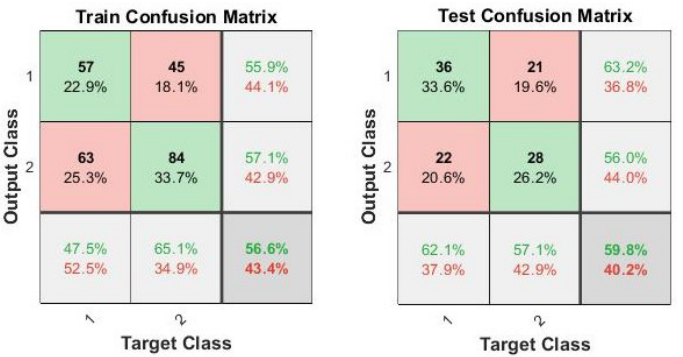
Figure 7. Confusion matrix of the cocoon-shape-selection procedure based on the logistic regression model as described in Section 2.3 (Class 1 stands for well-shaped cocoons; Class 2 stands for bad- shaped